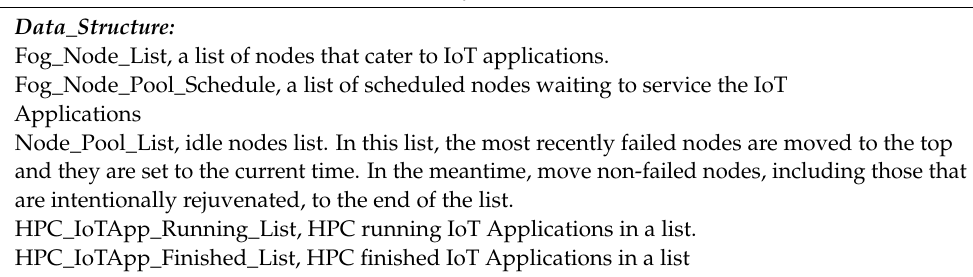
Algorithm 3: CRP Rule-Based Network